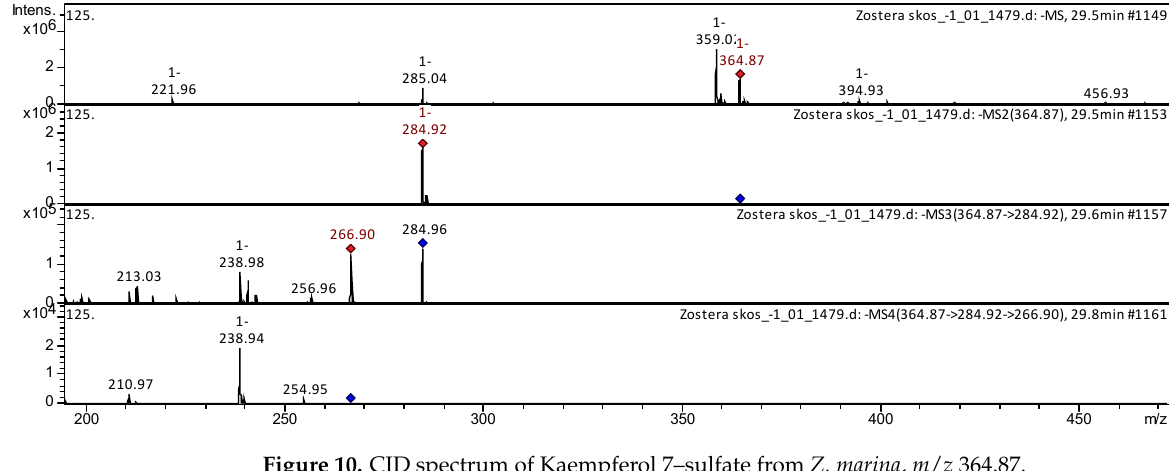
rina is shown in Figure 11. [M–H] – ion produced two fragment ions with m/z 358.92 and